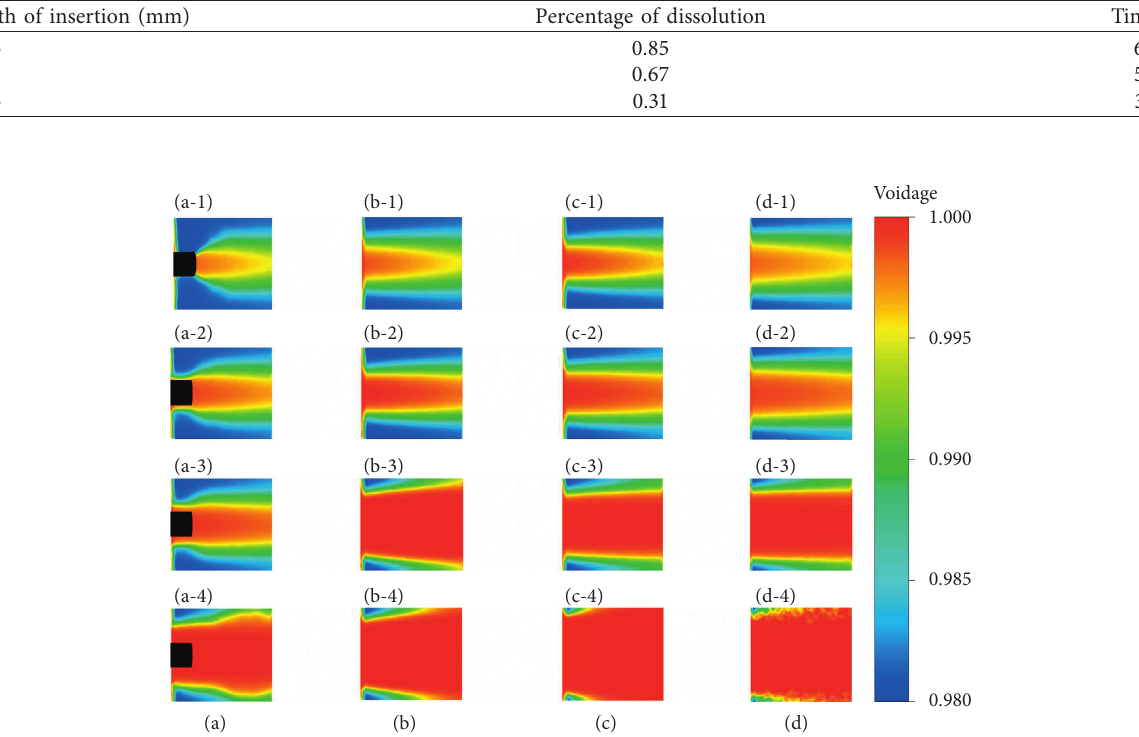
Figure 12: The voidage contours of 0.025mm inside the clot (a), and 0.1 mm (b), 0.2mm (c), and 0.3 mm (d) in the front of the clot to present the evolution of clot lysis.